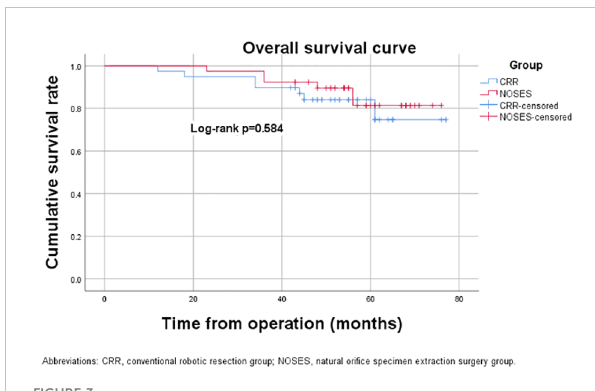
FIGURE 3 Overall survival curve. CRR, conventional robotic resection group. NOSES, natural ori fi ce specimen extraction surgery group.